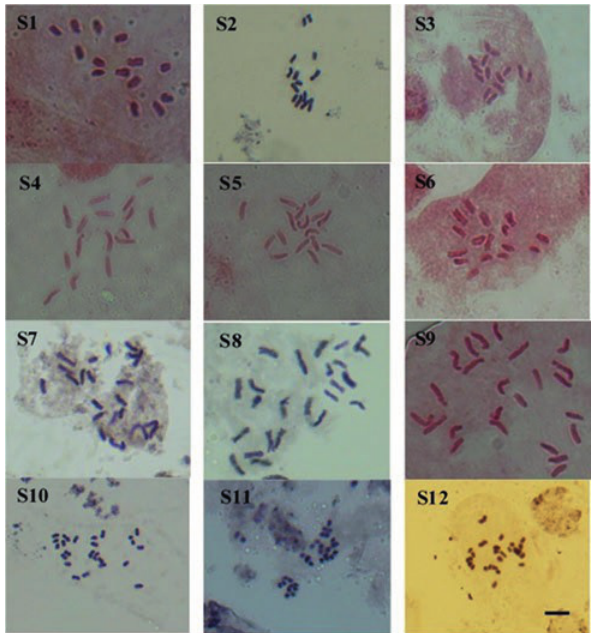
Figure 2. Somatic chromosomes of 12 berry species. Scale bar = 5